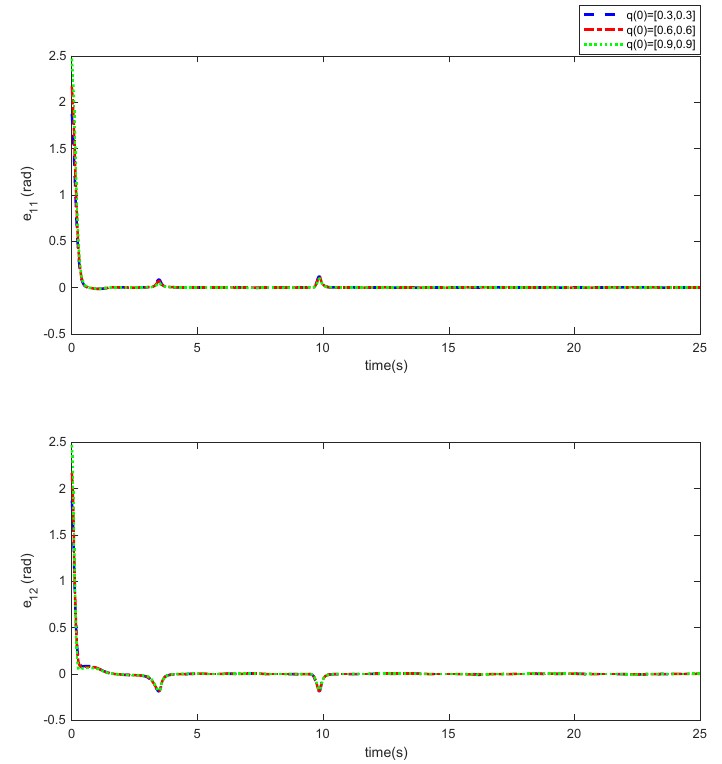
Figure 9. Trajectory of the tracking error based on Scenario 2.